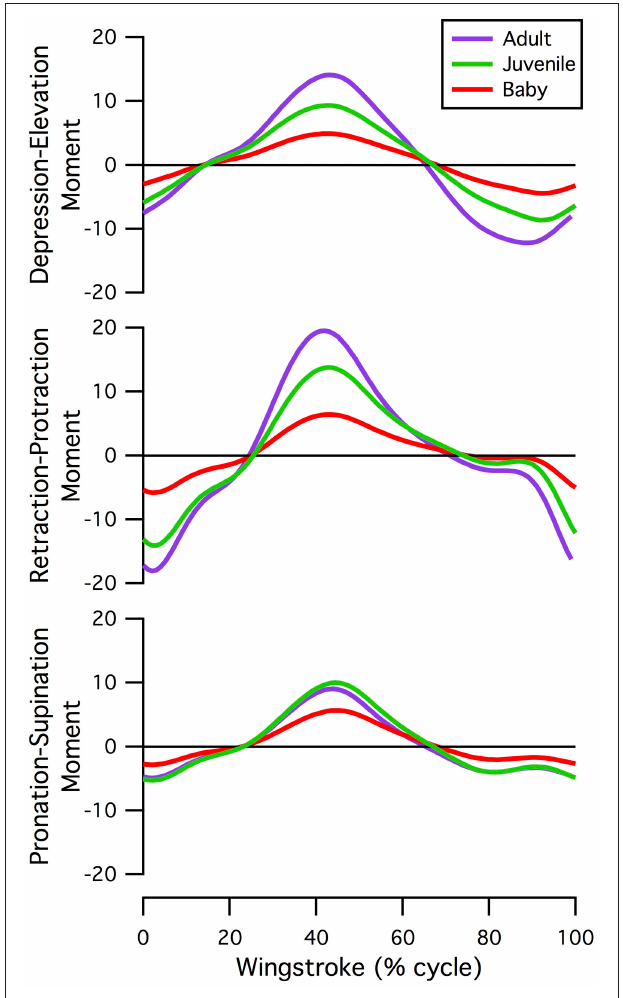
FIGURE 7 | Normalized shoulder moments. Moments at the shoulder joint, standardized by body weight and moment arm lengths of the pectoralis and supracoracoideus (averaged over one wingbeat); all models were simulated under identical conditions (adult kinematics and no aerodynamic force). Joint moments increase from baby to juvenile to adult, even when accounting for body